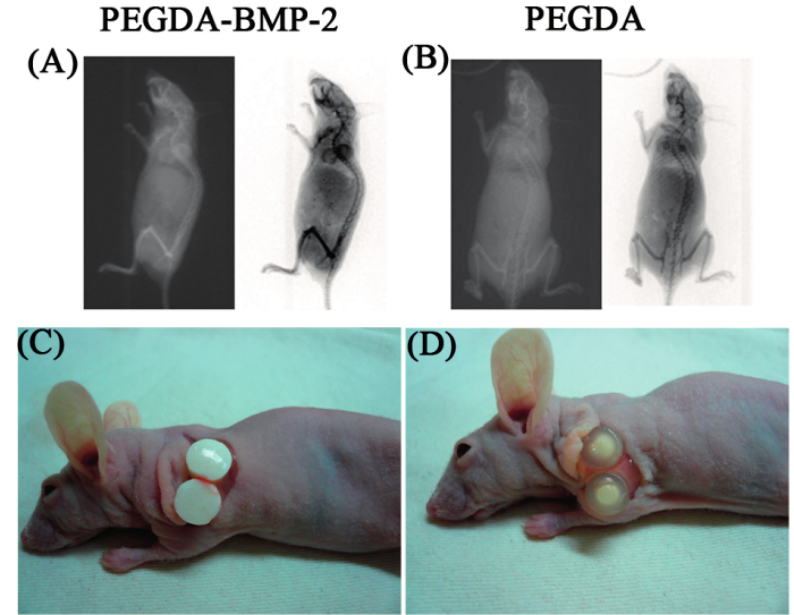
Figure 7. Radiographic assessment of nude mice model and gross morphology of LFs cultivated in PEGDA-BMP-2 ( A , C ) and PEGDA ( B , D ) photo-responsive hydrogels after 12-week